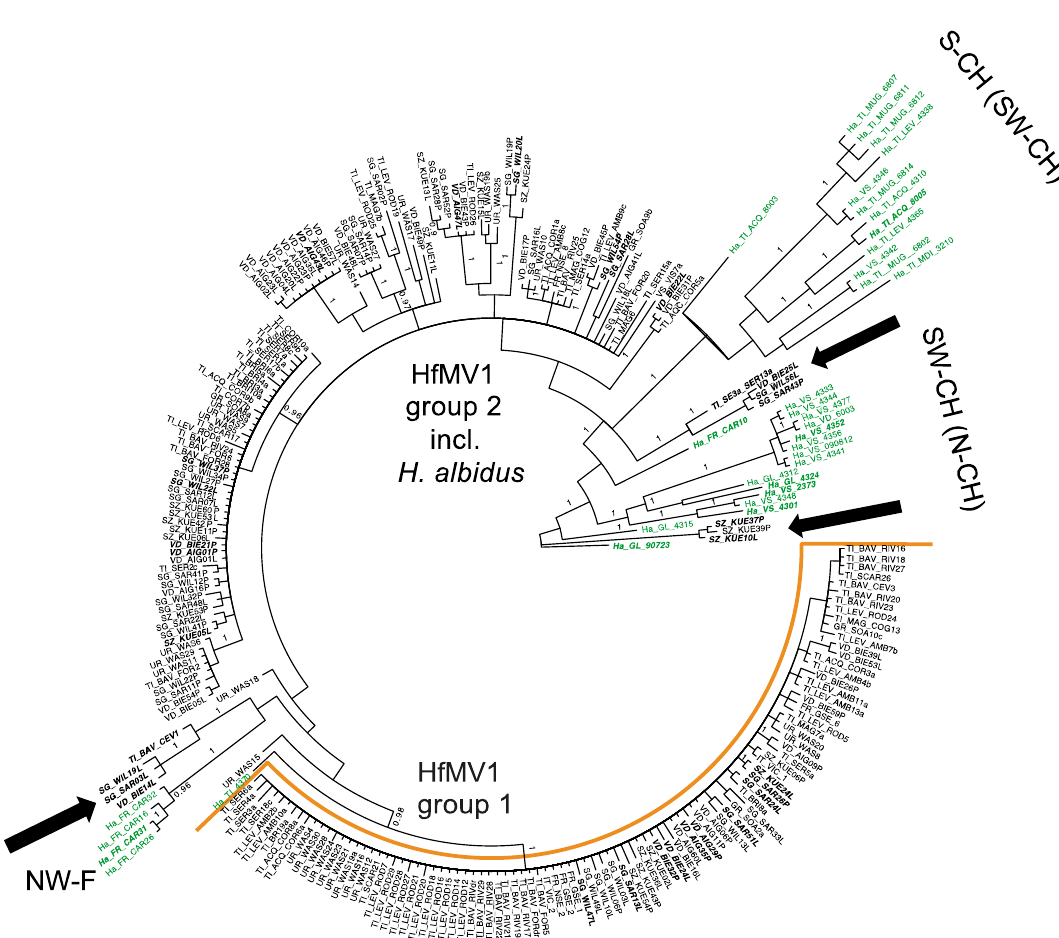
Figure 3. MrBayes analysis conducted with 255 sequences of the partial RdRP gene (495 bp) of the mitovirus HfMV1. Green color depicts H. albidus isolates. Posterior probabilities are shown at the respective branch if they were >0.95. Each sample is named with the sampling year, followed by the sampling locality (for abbreviation see Table 1) and sample name. Arrows indicate intermixing of H. albidus and H. fraxineus HfMV1 sequences. Samples marked in bold and italics are included in the full-length analysis.